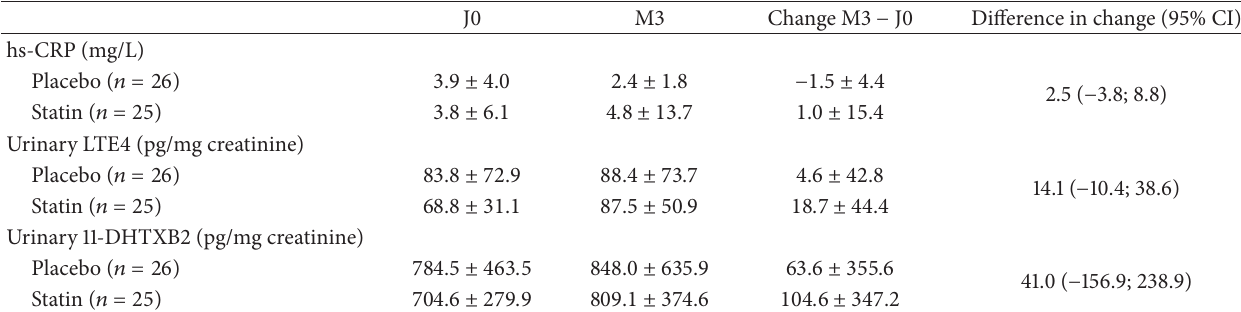
Table 5: Inflammatory parameters at baseline (J0) and after 12 weeks (M3) of placebo or statin treatment. J0 M3 Change M3 −